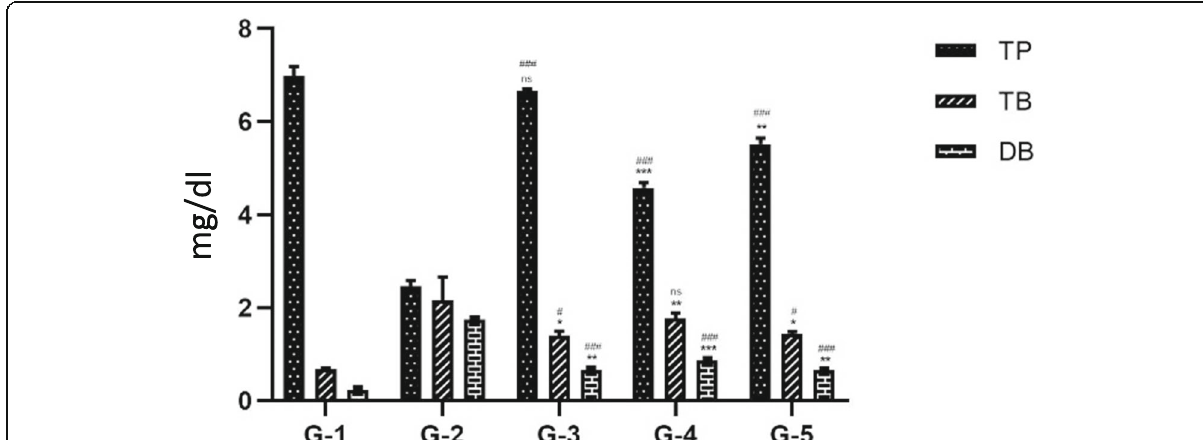
Fig. 3 Effect of GFME on enzyme TP, TB, and DB levels in blood serum of CCl 4 induced hepatotoxicity. Values are mean ±S.E.M. symbol represent statistical significance; *#p<0.02, **##p<0.001 and ***###p<0.0001.* indicates the comparison of G- 1 with G-3, G- 4, G-5; # indicates the comparison of